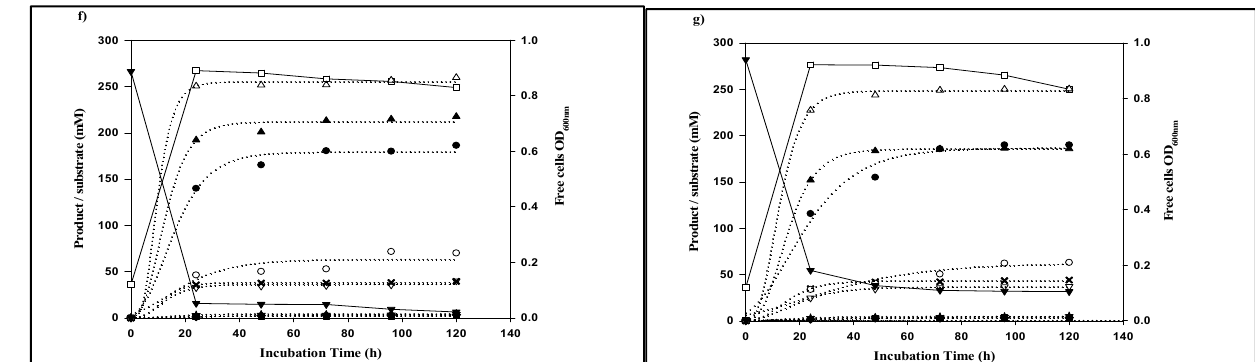
Figure 5. Glycerol fermentation profiles for a co-culture of Enterobacter spH1 and Citrobacter freundii H3 on support: ( a ) control without support (FC); ( b ) Fe 2 O 3 ; ( c ) γ -Al 2 O 3 ; ( d ) SiO 2 ; ( e ) Fe/SiO 2 ; ( f ) AC; ( g ) Fe/AC. Residual glycerol ( ), ), glycerol consumed ( Δ ), lactate ( ✖ ) acetate ( ■ ), 1,3-propanediol ( ), ethanol ( ▲ ), butyrate ( ♦ ), succinate( ★ ),formate ( ), H 2 ( ● ), CO 2 ( ), pH( ) and OD 600 nm ( ). The data was fitted using the modified Gompertz equation (Equations (1) and (2)) (dotted lines).